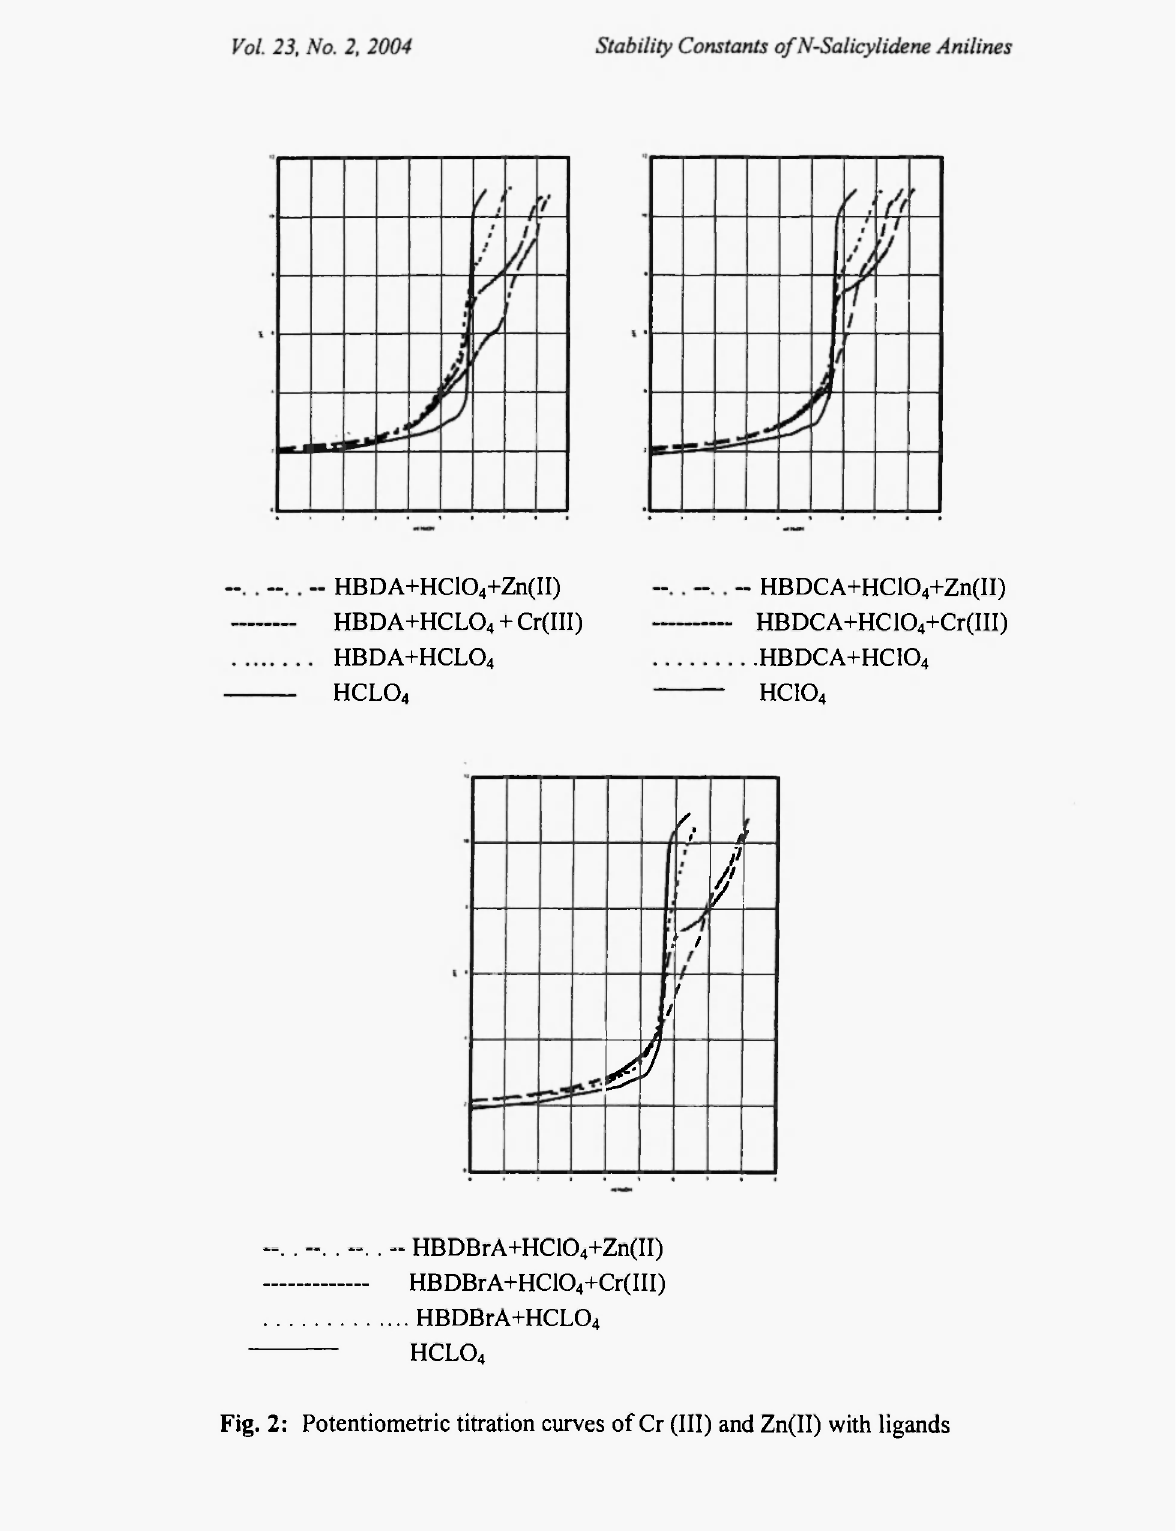
Fig. 2: Potentiometrie titration curves of Cr (III) and Zn(II) with ligands